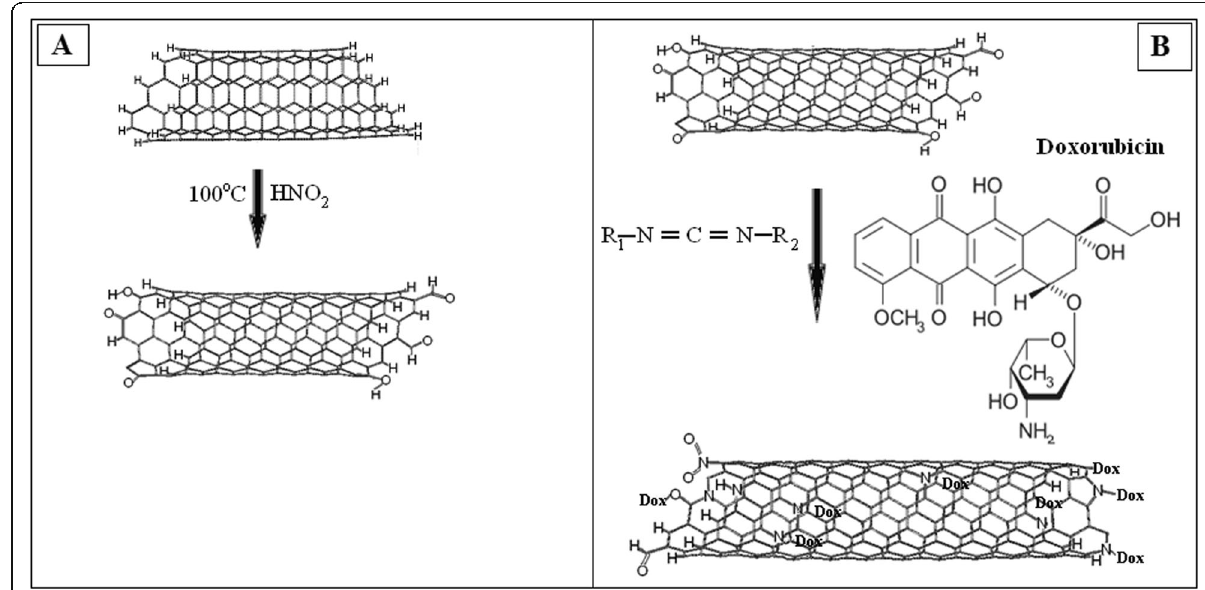
Fig. 1 a Scheme of reaction of CNTs with carbodiimide. b Scheme of the functionalization of the CNTs by